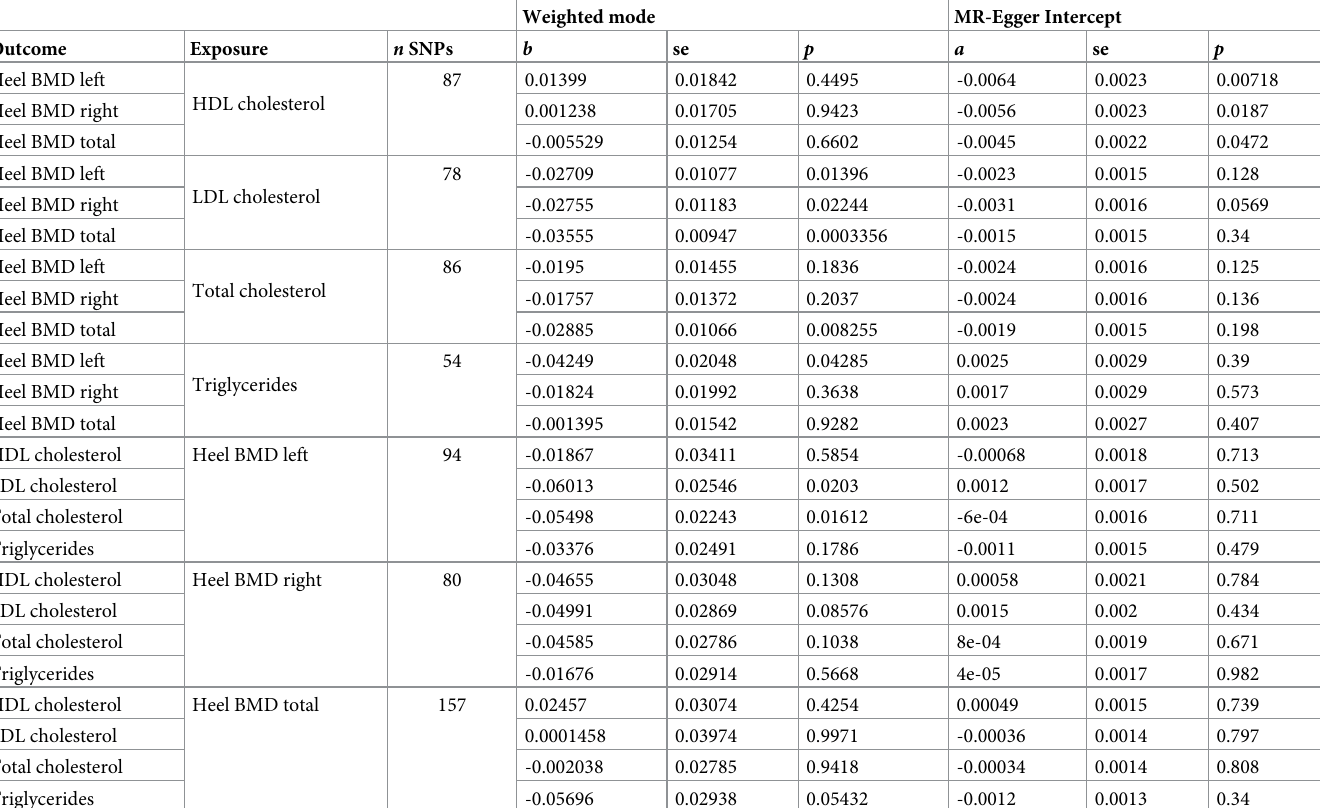
Table 7. Bidirectional MR tests for lipids and